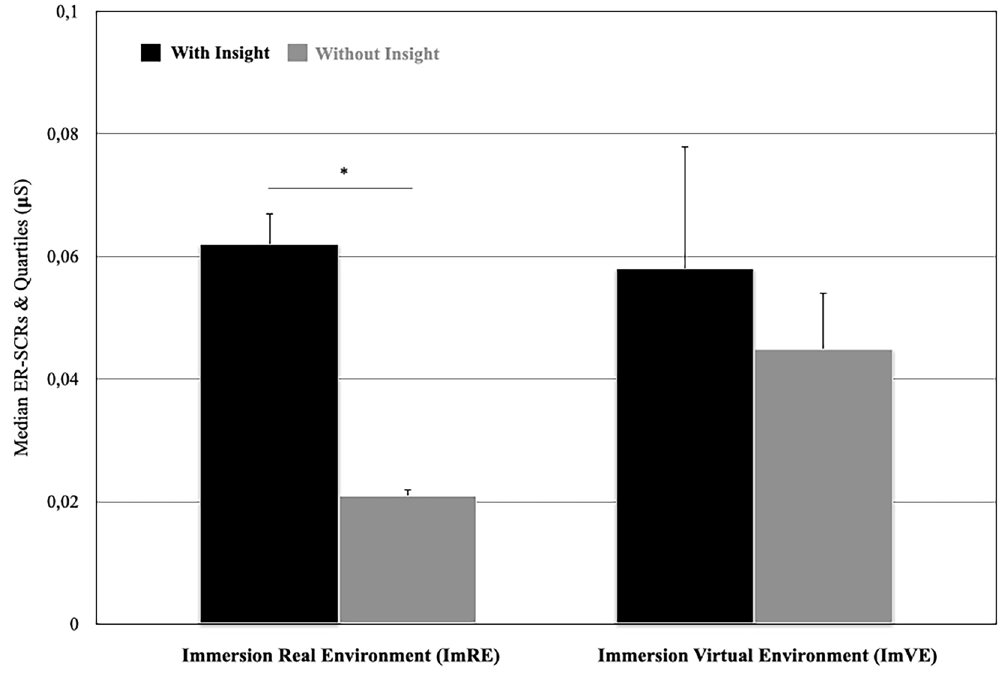
Figure 6. Median SCR comparisons for "primed" participants “with” and “without” insight during immersion into real (ImRE) and virtual (ImVE) environments (* p < 0.05).